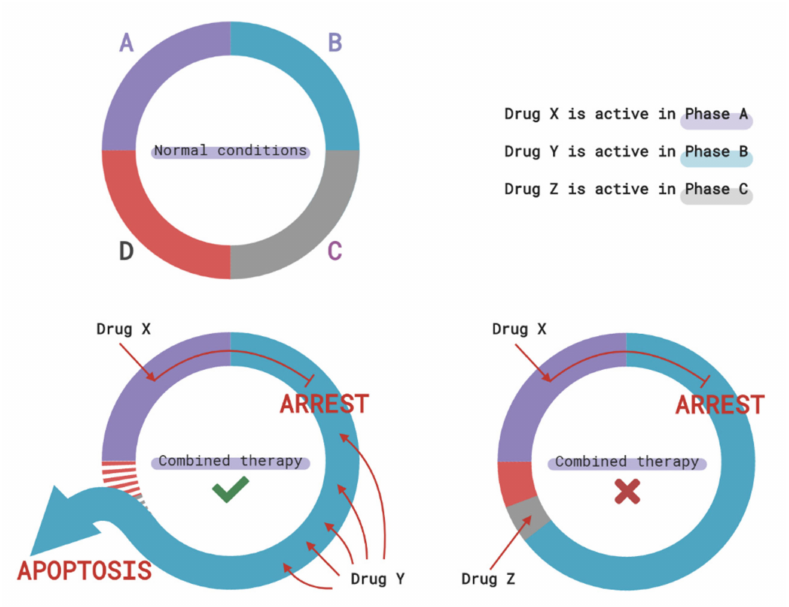
Figure 3. The success of combined therapy depends on the cell cycle. The use of chemotherapeutic drugs that depend on the phase of the cell cycle and cause its arrest may lead to both higher and lower e ff ectiveness of the combined therapy. Arresting the cell cycle in a phase corresponding to the maximum e ff ectiveness of the second drug prolongs its time of action. Arresting the cell cycle in a phase preceding the action of the second drug impairs its e ff ects. A, B, C, and D represent 4 phases of the cell